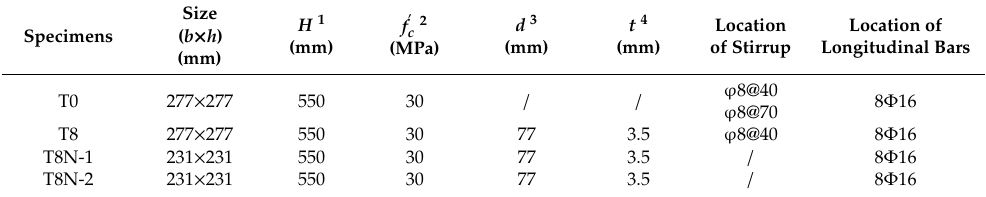
Table 1. Detailed parameters of the